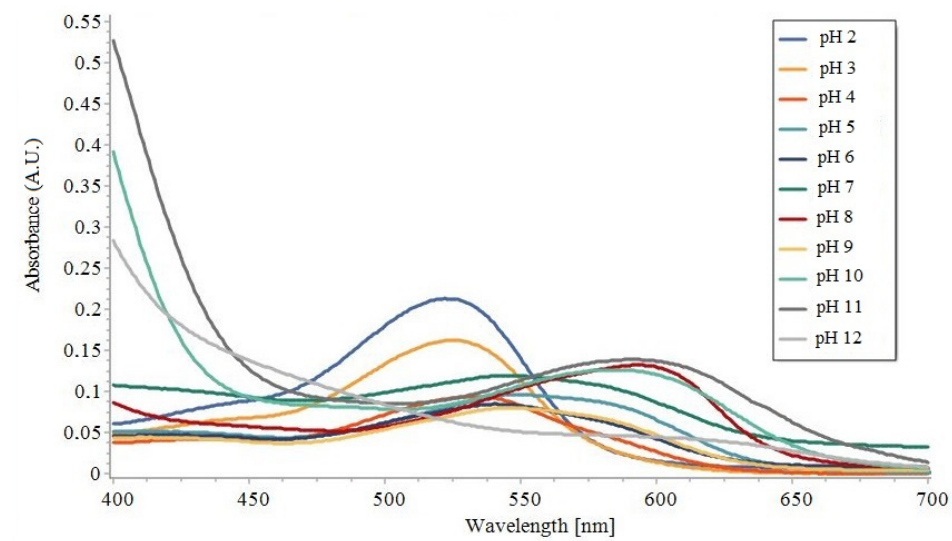
Figure 4. UV-Vis absorbance spectra of the BCE solutions at pH 2–12.